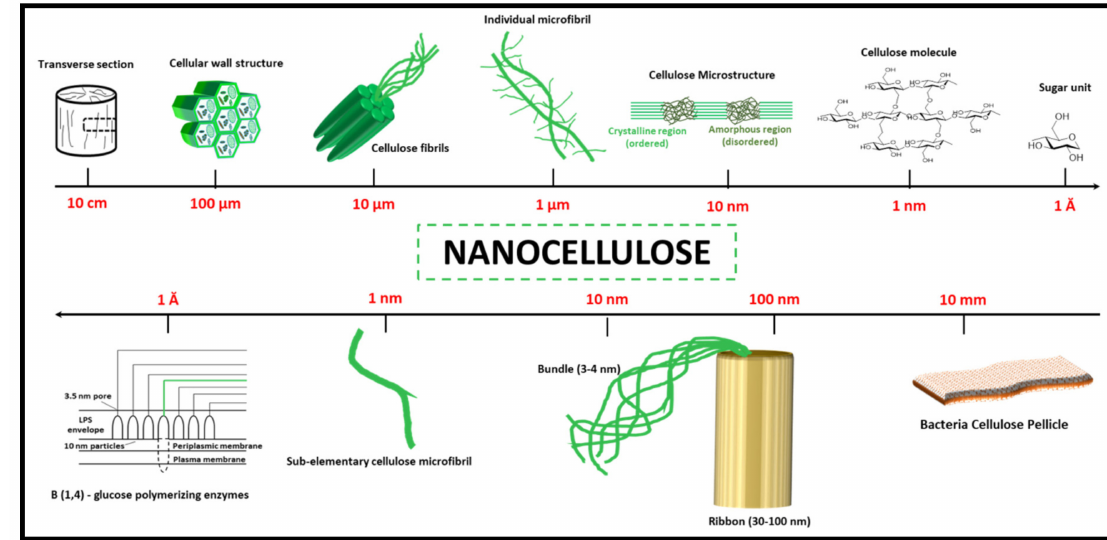
Figure 1. The hierarchical structure of cellulose. The upper part: plant cellulose; the lower part: bacterial cellulose. Adapted from [35]. Copyright, 2014,